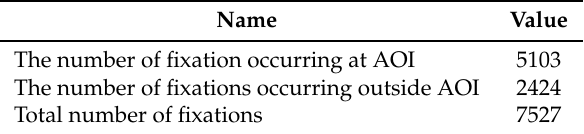
Table 3. The number of fixations taking into account the area of their occurrence.